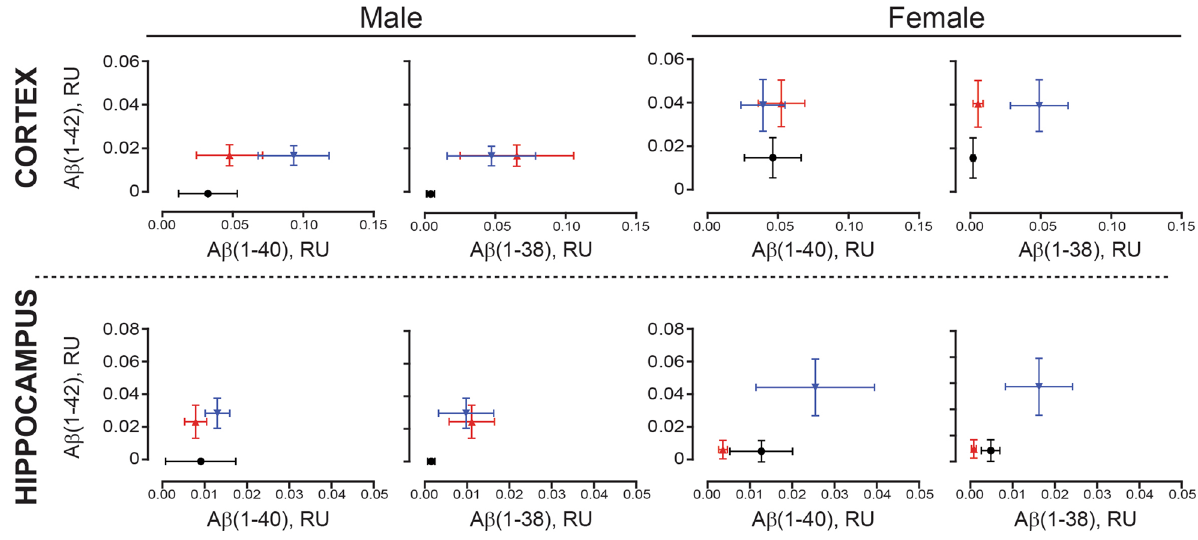
Figure 9. Aβ levels from cortical and hippocampal extracts were visualized as gnu plots. Cortical ( top panels ) and corresponding hippocampal ( bottom panels ) levels of Aβ(1–42), Aβ(1–40), and Aβ(1–38) were compared using gnu plots (mean ± sem). Control values are shown in black (filled circle), EOAD values are shown in blue (filled inverted triangle); LOAD values are shown in red (filled triangle).